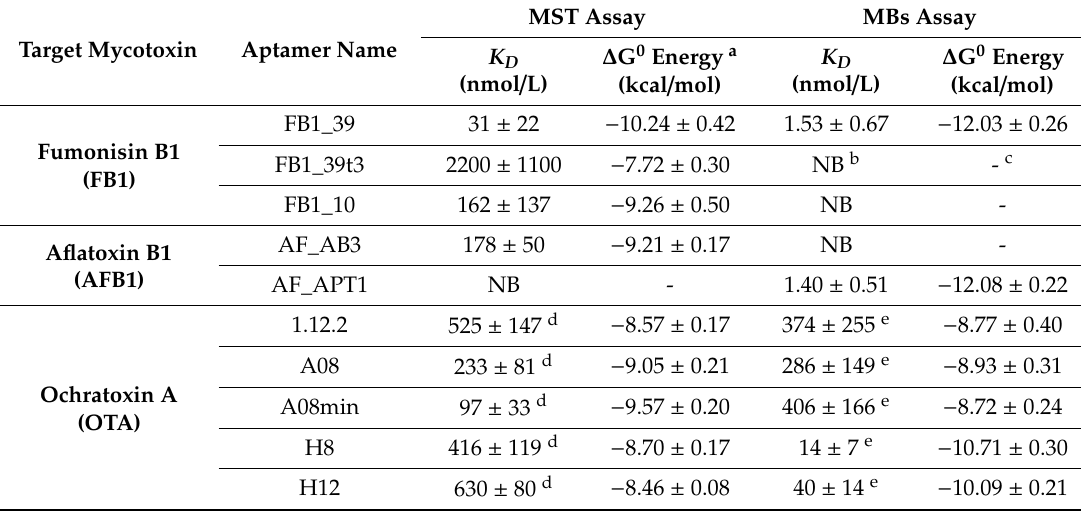
Table 3. Dissociation constant ( K D ) values and corresponding free energy ( ∆ G 0 ) values calculated by using Fluorescent Microscale Thermophoresis (MST) and magnetic beads (MBs) assays of selected aptamer towards target mycotoxins. The standard error values of the calculated K D values were derived from two independent